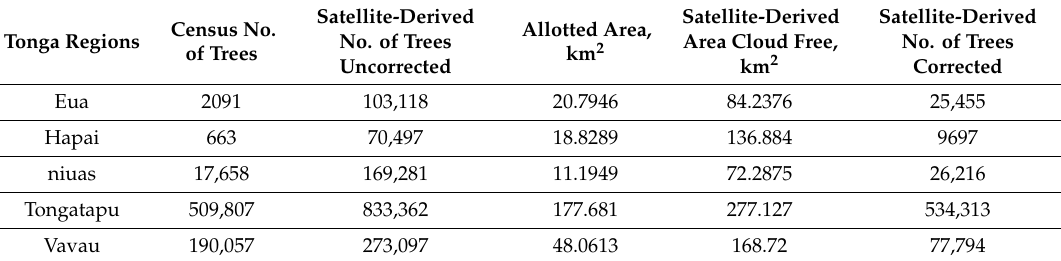
Table 1. Comparison of the algorithm coconut tree counts to the results published in the 2015 agricultural census over the di ff erent parts of the Tonga archipelago.